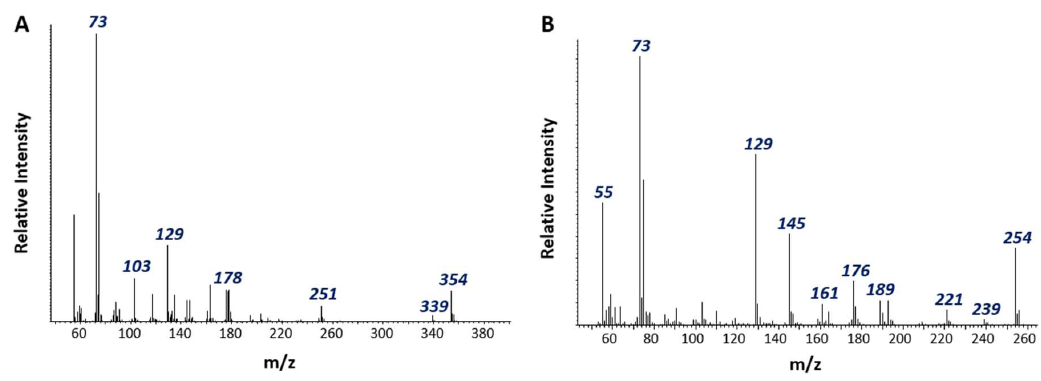
Figure 2. Mass spectra of silylated GC-MS peaks tentatively identified as ( A ) cyclohexane dicarboxylic acid and ( B ) an isomer of deahydro-2-naphthoic acid detected in